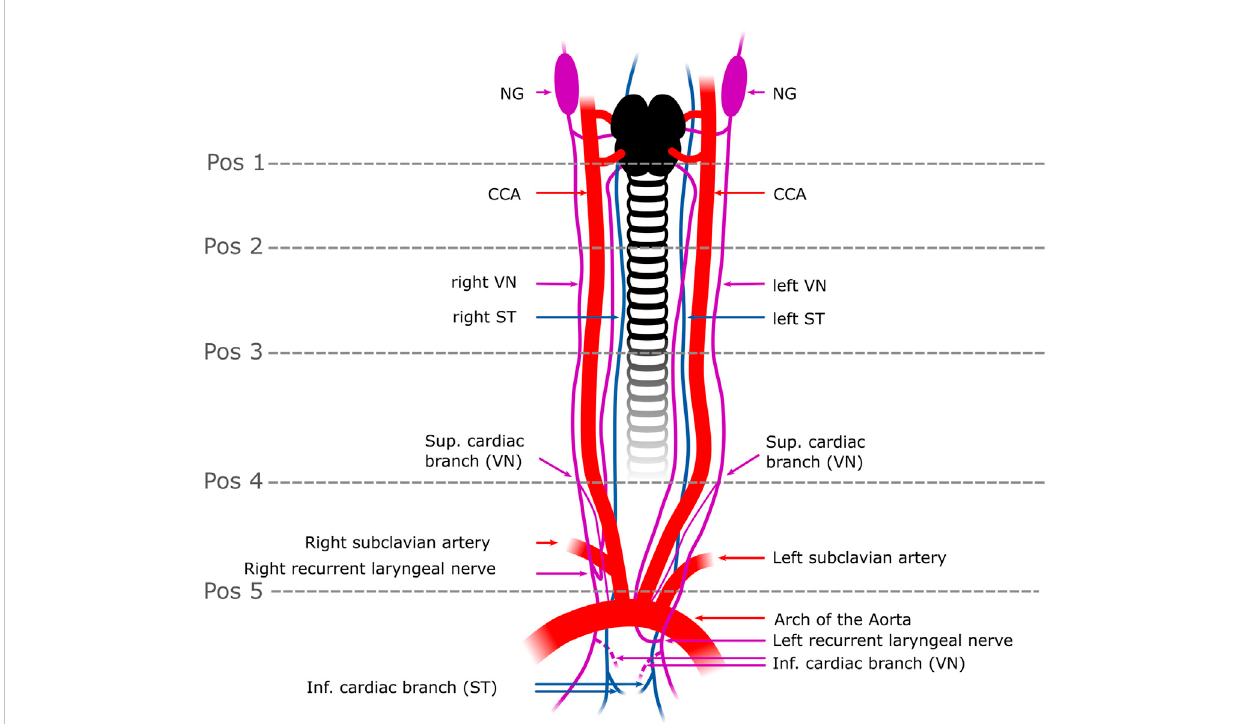
FIGURE 1 Schematicoverviewofthesurgicalwindowinapig.TheVNcanbedistinguishedfromtheSTbyidenti fi cationoftheNG.Insomeindividuals,thetwo nerves were observed to merge or split at the cervical level. In rabbits, the VN and the ST were travelling individually next to each other to the cardiac plexus. Five anatomical positions (pos 1-pos 5) were de fi ned from cranial to caudal at which the fascicle number and nerve areas were measured. The superior CB was the branch used in this study (one superior CB per nerve) and harvested right above the level of the subclavian artery (pos.5); the inferior CB (indicated as dashed lines) was not used in this study since its anatomical position in the epicardial fat is surgically less feasible for selective stimulation than the superior CB. Pos. 1-3 label the upper to the mid-cervical level. Pos. 4 indicates the cardiac branching point of the superior CB. NG, nodose ganglion; CCA, common carotid artery; VN, Vagus Nerve; ST, Sympathetic trunk; Pos, position; sup. cardiac branch, superior cardiac branch; inf. cardiac branch, inferior cardiac